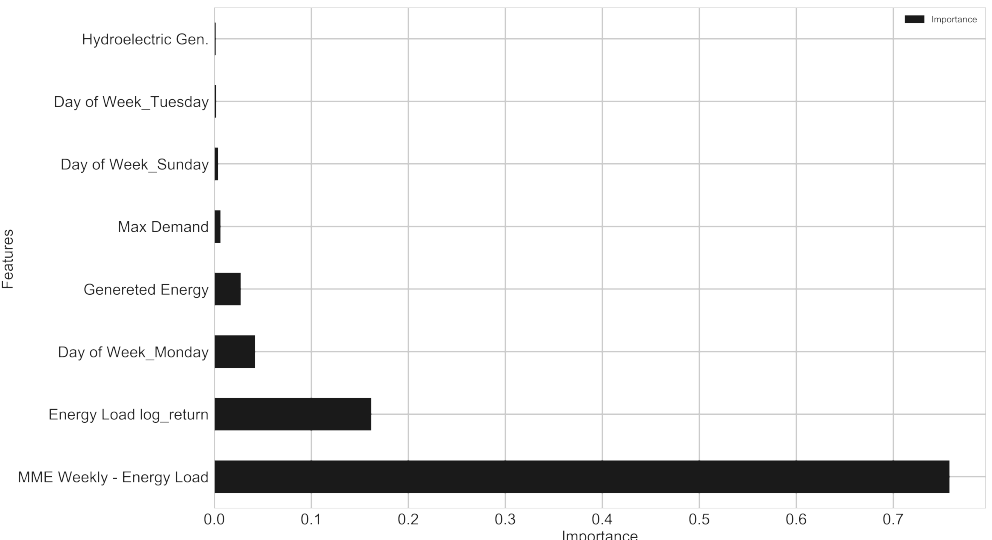
Figure 9. Importance of variables when predicting the Energy Load by the tuned GB.